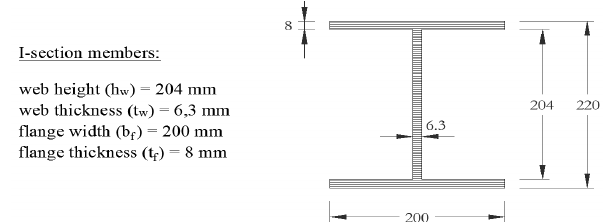
Figure 4. Steel cross section of columns and beams used by De Grandi [14]. Source: De Grandi [14]